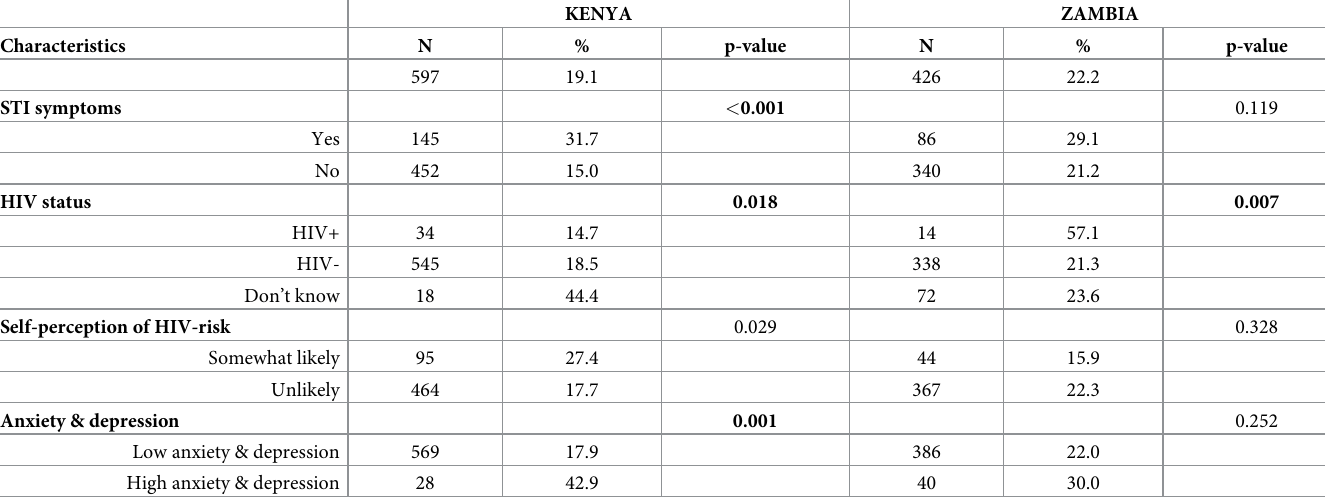
Table 3. Bivariate associations between experience of IP sexual violence and health outcomes, Kenya and Zambia. KENYA